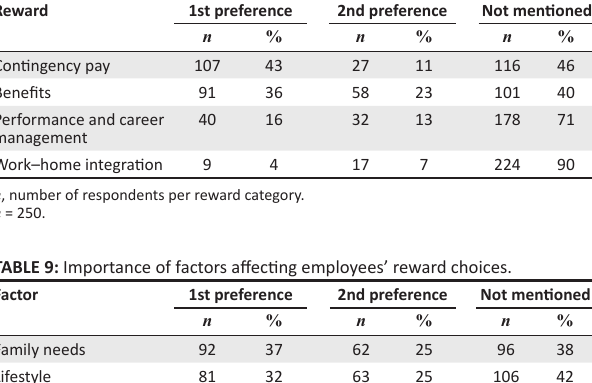
TABLE 8: Importance of rewards in total reward package. Reward